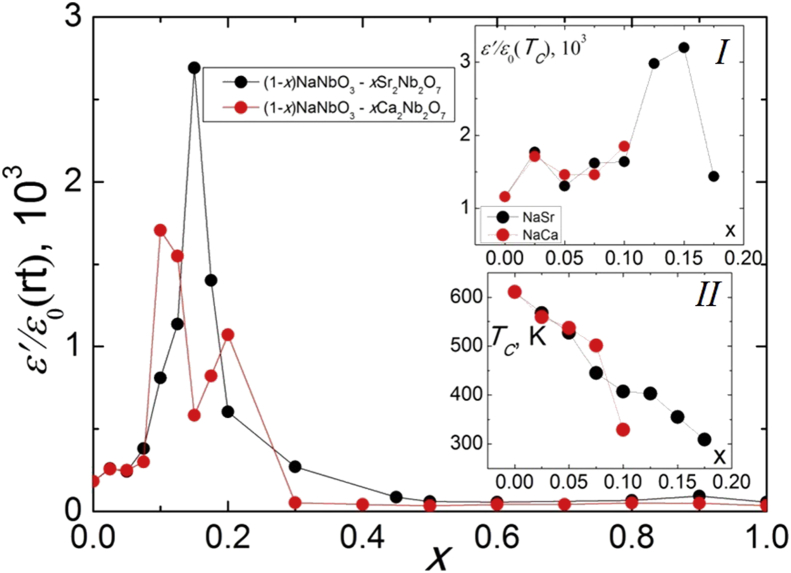
Dependences of ε′/ε0(RT) (x), ε′/ε0(Tc) (x) (inset I) and TC(x) (inset II) for NCN and NSN solid solutions.